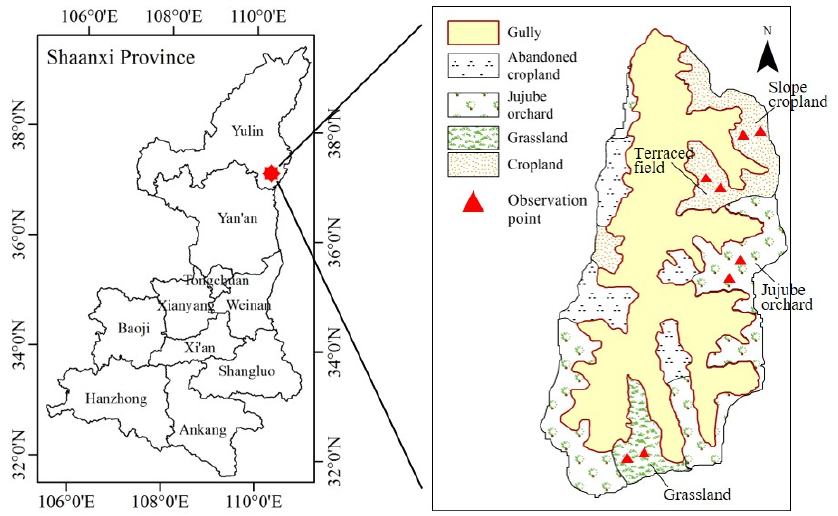
Figure 1. Location of the study area and distribution of experimental land use types.